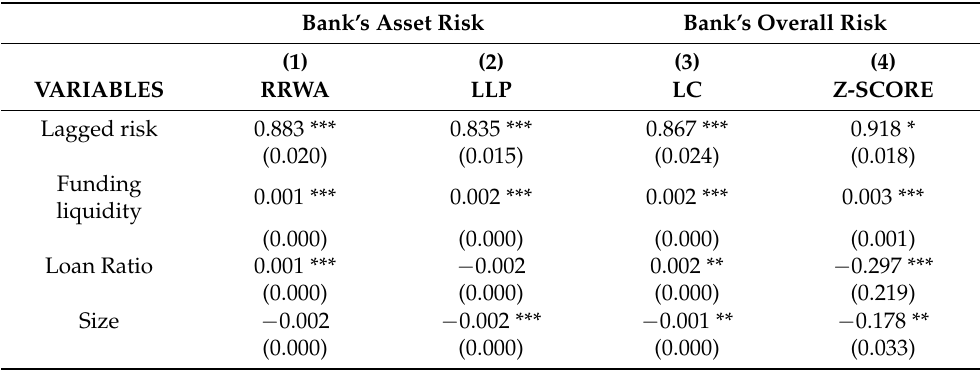
Table 3. Impact of funding liquidity ratio on